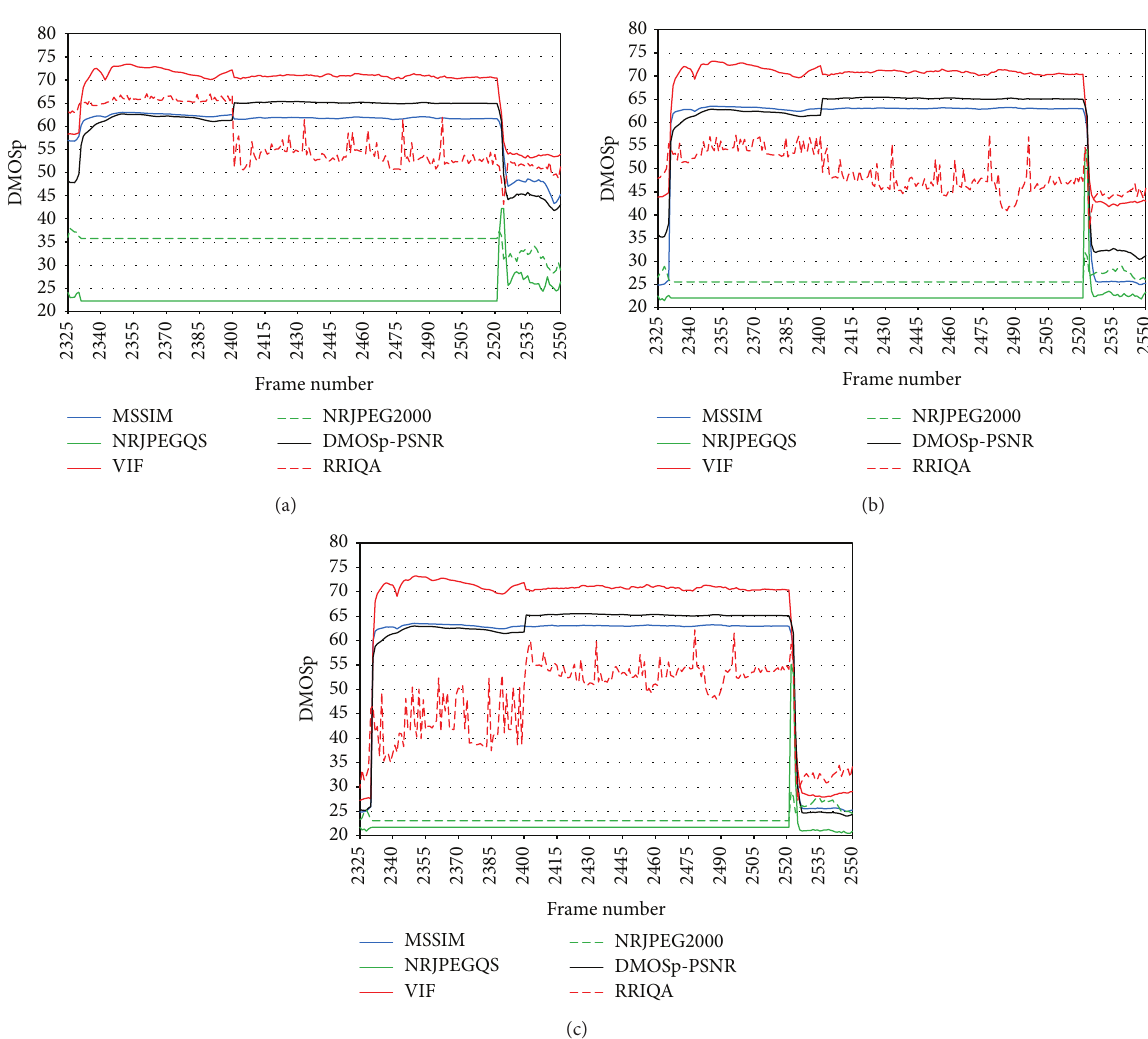
Figure 10: Metric comparison in the DMOSp space during a very large burst.